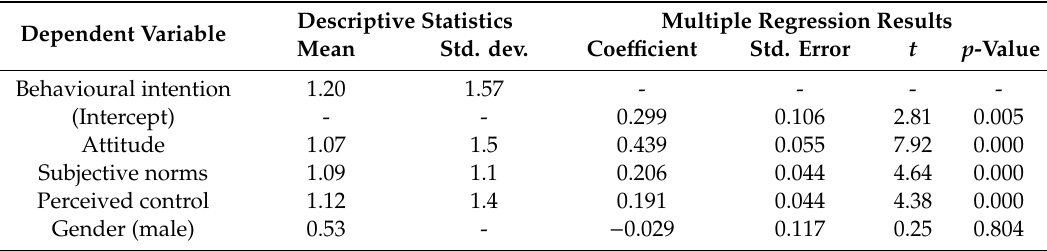
Table 1. Descriptive statistics and multiple regression results (dependent variable: behavioural